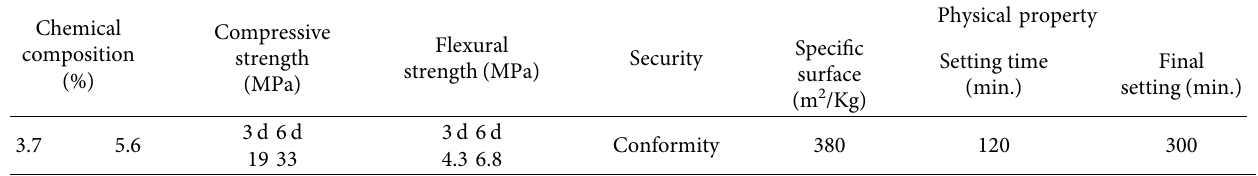
Table 2: Technical performance of cement.